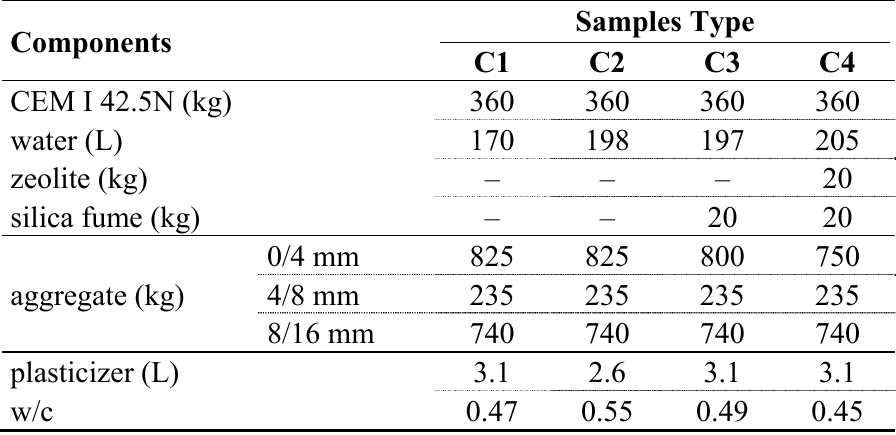
Table 2. Mixture composition of tested